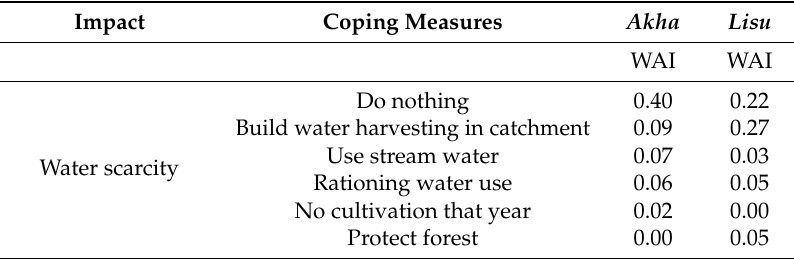
Table 6. Adaptation measures to climate change